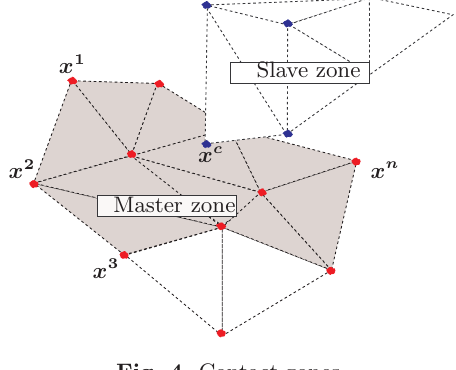
Fig. 3. Node-to-facet contact element. Fig. 4. Contact